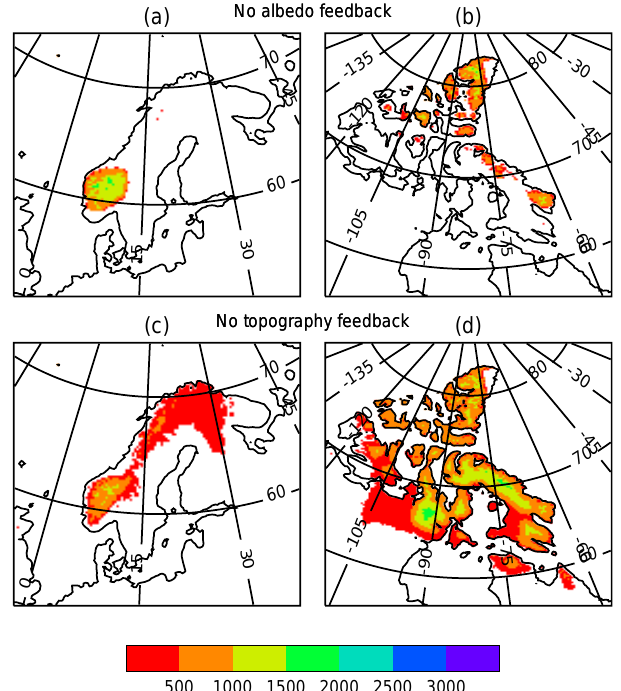
Fig. 15. Ice-sheet time-mean thickness ( m ) in the steady state for the incipient glacial climate ( a , b ) without albedo feedback, ( c , d ) with- out topography